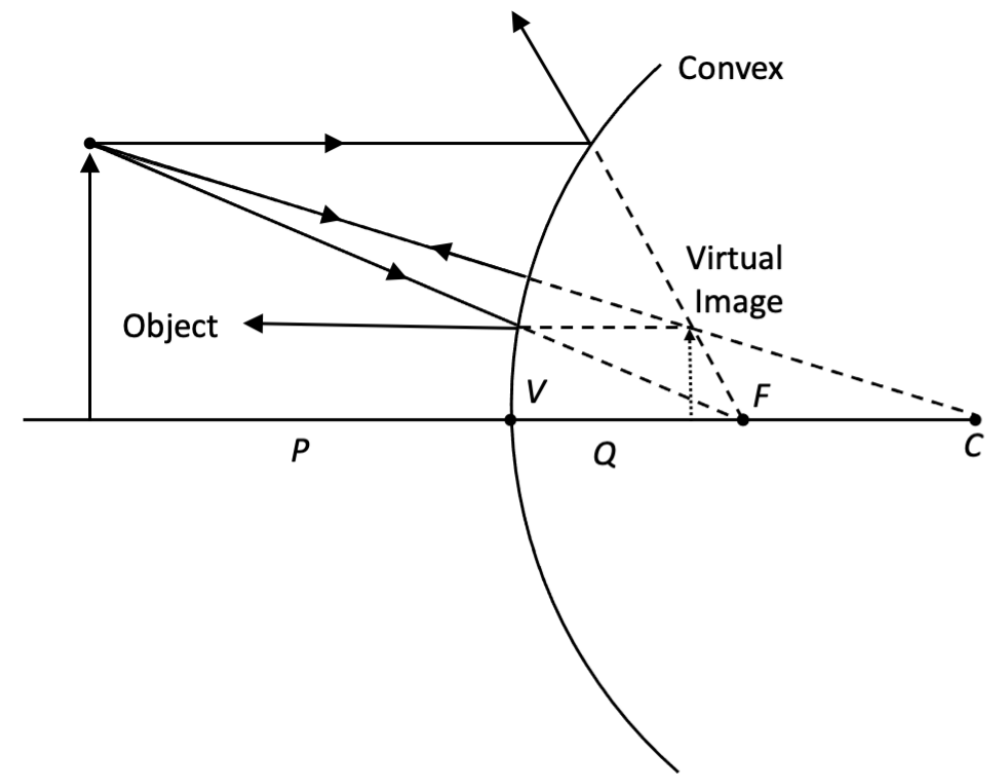
Figure 2. Graphical ray tracing for the convex cylindrical mirror (view from the axis of the cylinder).